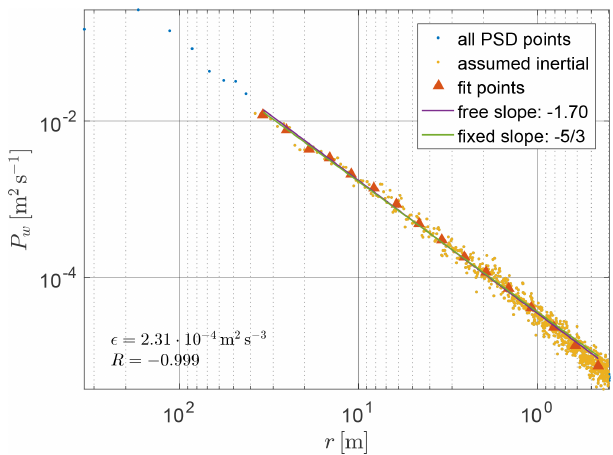
Figure 8. Example of (cid:15) derivation with power spectrum method (flight no. 5, LEG307, vertical component). Computed PSD (blue) is resampled in the assumed inertial range (yellow) to obtain log- arithmically spaced points (triangles) which are used for least- squares fits: one with free slope (Eq. 15, purple), one with fixed theoretical slope (Eq. 14,